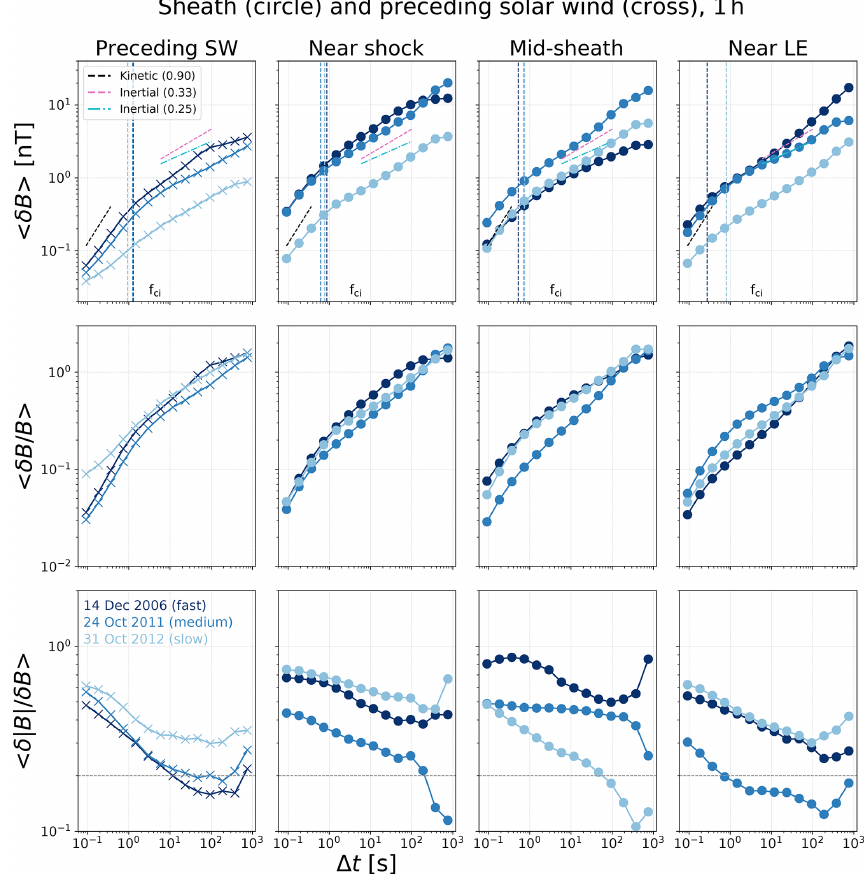
Figure 3. Means of fluctuation amplitudes (cid:104) δB (cid:105) , normalised fluctuations (cid:104) δB/B (cid:105) , and fluctuation compressibility (cid:104) δ | B | /B (cid:105) as functions of timescale (cid:49)t . Results are shown separately for the preceding solar wind (crosses) and three different regions of the sheaths (circles). Different colours represent fast (dark blue), intermediate speed (medium blue), and slow (light blue) sheaths. The dashed vertical lines show the ion cyclotron scales calculated using the magnetic field magnitude averaged over the region in